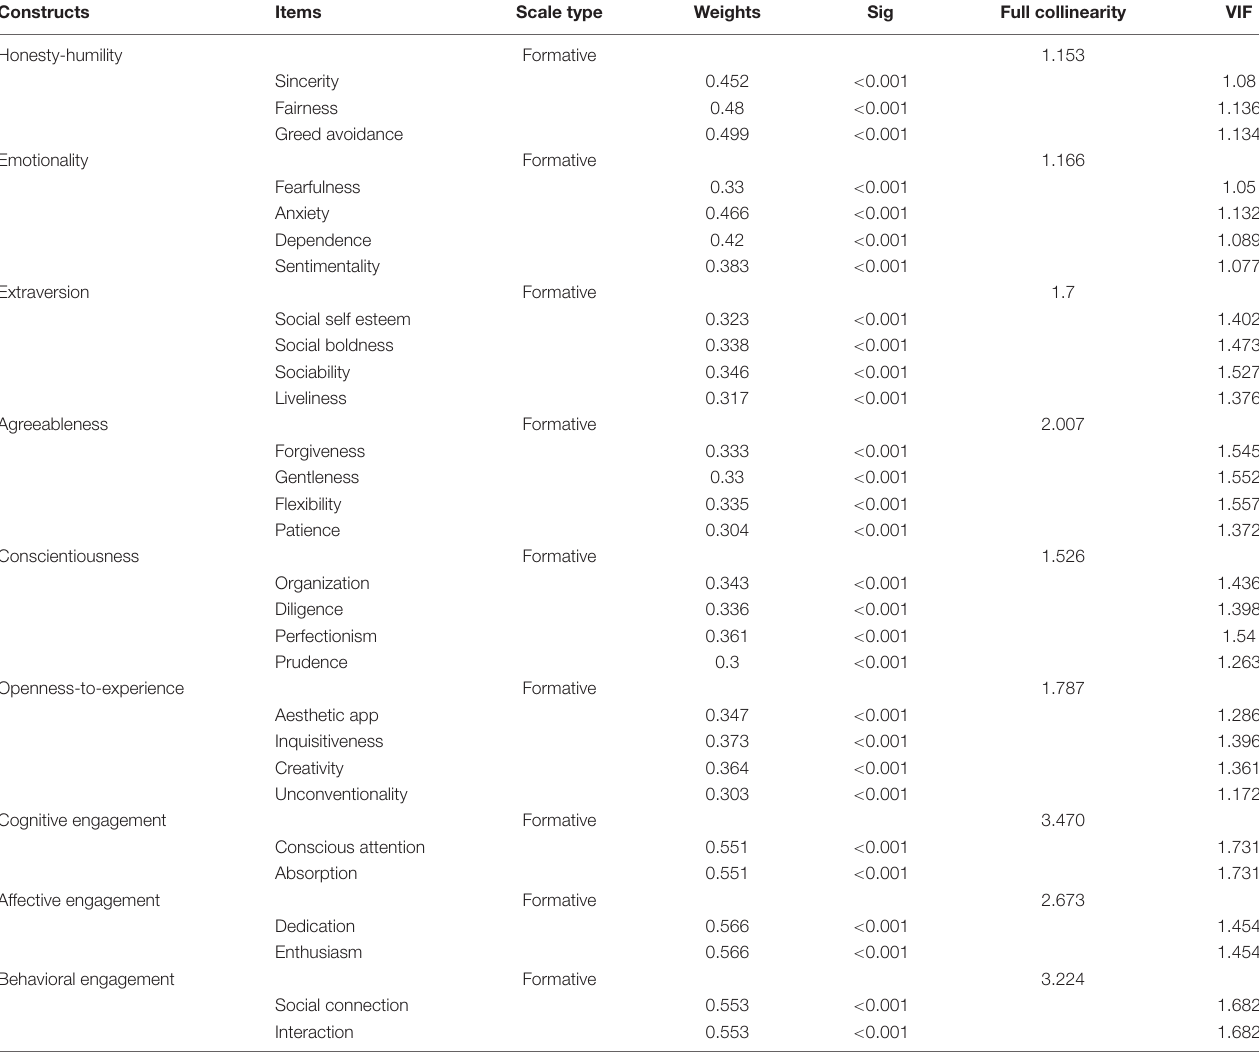
TABLE 4 | Assessment of the measurement model on second-order formative constructs (e.g., honesty-humility, emotionality, and etc.). Constructs